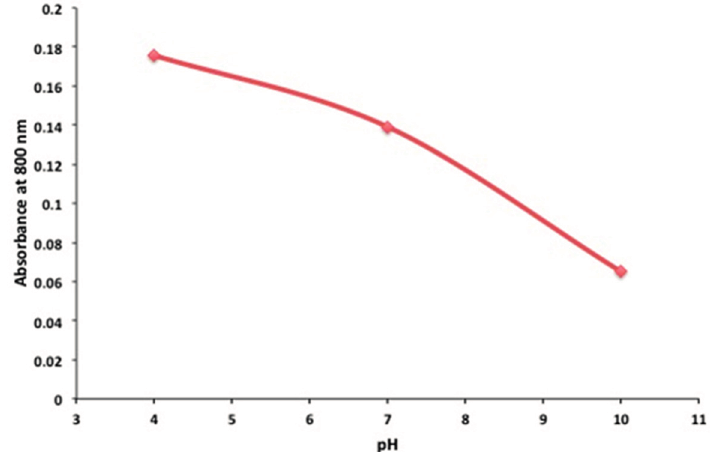
Figure 8. Absorbance change with pH at 800